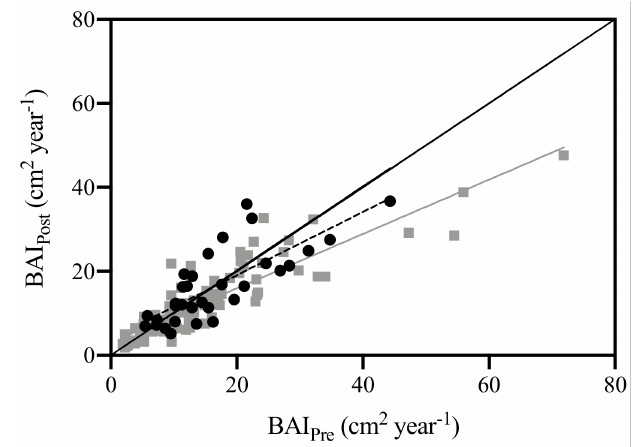
Figure 4. Relationship between BAI after and before drought episodes. Black circles and the black dashed line indicate the values and linear regression (BAI Post = 0.7529BAI Pre + 3.344) of P. kesiya ( n = 32); grey squares and the grey solid line indicate the values and linear regression (BAI Post = 0.6466BAI Pre + 3.025) of P. dalatensis ( n = 103). Solid black line, 1:1 ratio. Linear regression of PIDA ( grey solid line ) differs significantly from the